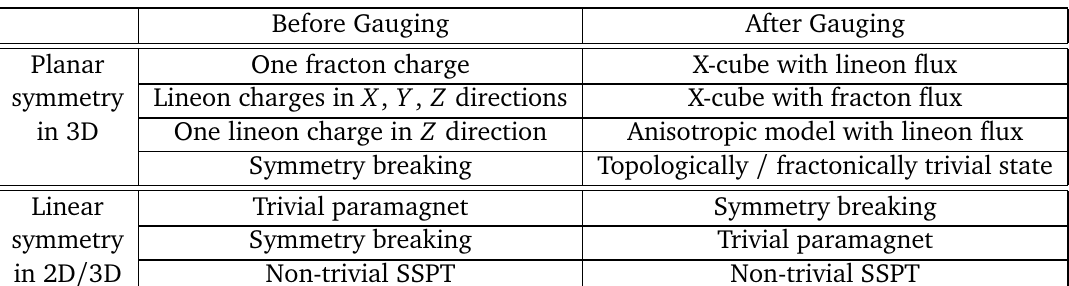
Table 1: Correspondence between phases with subsystem symmetries and gauge the- ory phases. The X-cube and anisotropic model listed refer to the corresponding foli- ated fracton phase, not to the specific model. Before Gauging After Gauging Planar One fracton charge X-cube with lineon flux symmetry Lineon charges in X , Y , Z directions X-cube with fracton flux in 3D One lineon charge in Z direction Anisotropic model with lineon flux Symmetry breaking Topologically / fractonically trivial state Linear Trivial paramagnet Symmetry breaking symmetry Symmetry breaking Trivial paramagnet in 2D / 3D Non-trivial SSPT Non-trivial